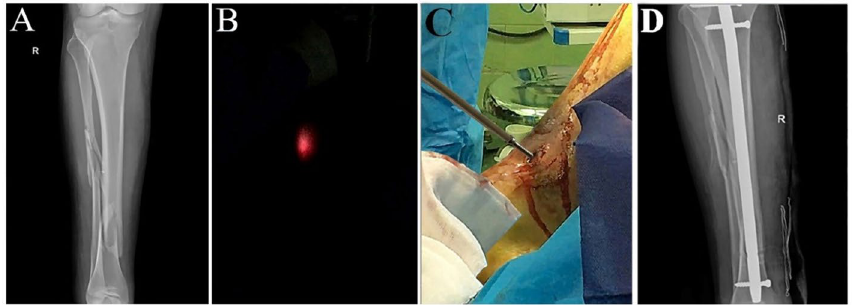
Figure 5 . Interlocking of the intramedullary nail by the laser system, ( A ) X-ray image of the patient’s right foot before the surgery, ( B ) Finding drilling position by the IMN holes laser indicator in the dark surgery room, ( C ) Interlocking the IMN, ( D ) The X-ray image of the patient’s right foot one day after intramedullary nailing.